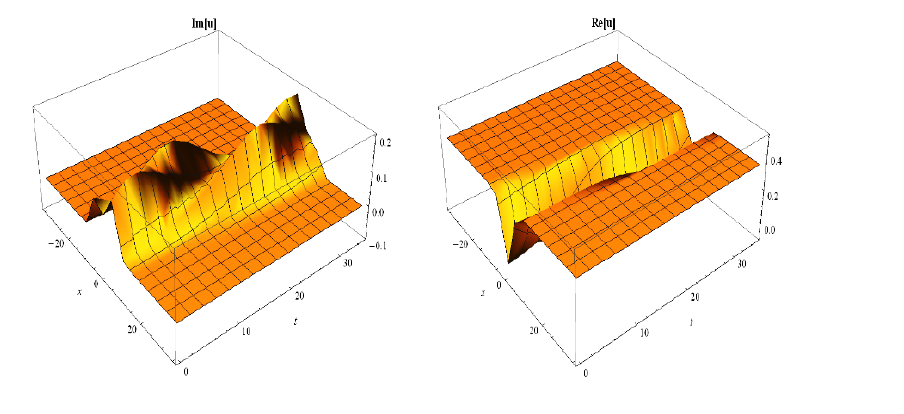
Figure 3. Three-dimensional graphs of imaginary and real part of (20).